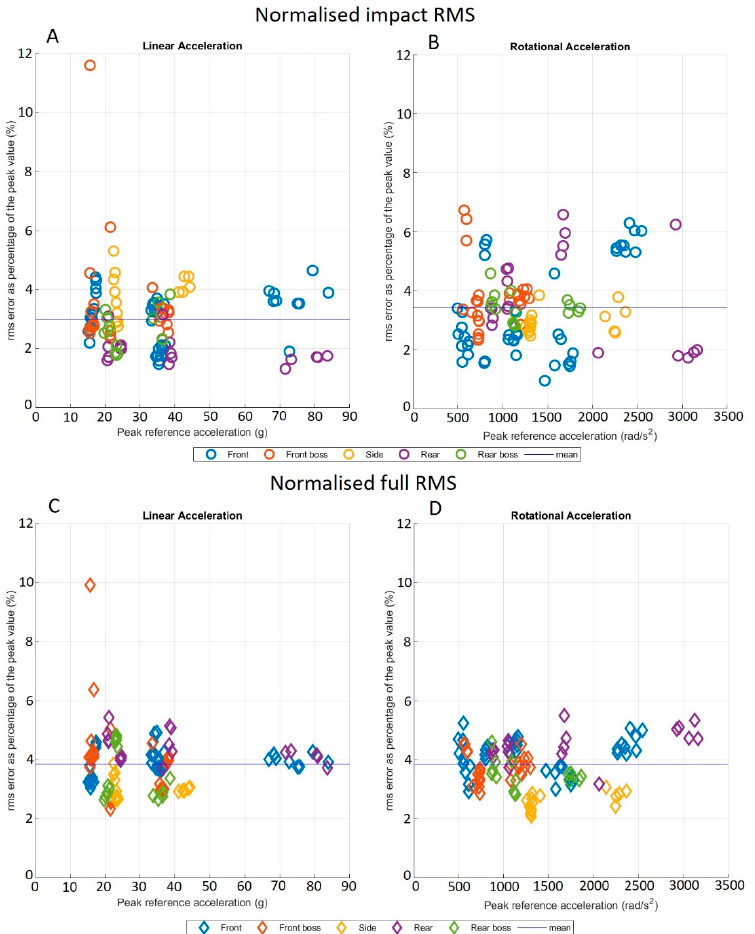
Figure 4. Normalised RMS values calculated over two different time periods for both linear and rotational accelerations. ( A , B ) Normalised impact RMS, ( C , D ) Normalised full RMS. The blue line shows the respective means. The colors show the impact location for each of the impacts.